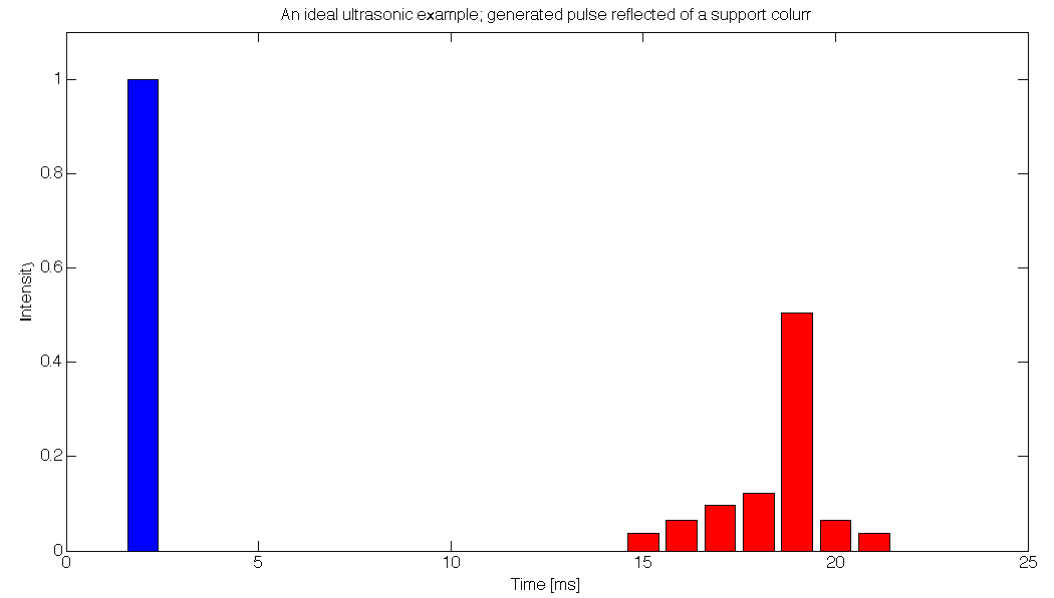
Figure 5. An ideal example depicting a generated ultrasonic burst (blue column) and its reflected version in time series (red columns), where the maximum reading was used to produce a maximum response of the support column